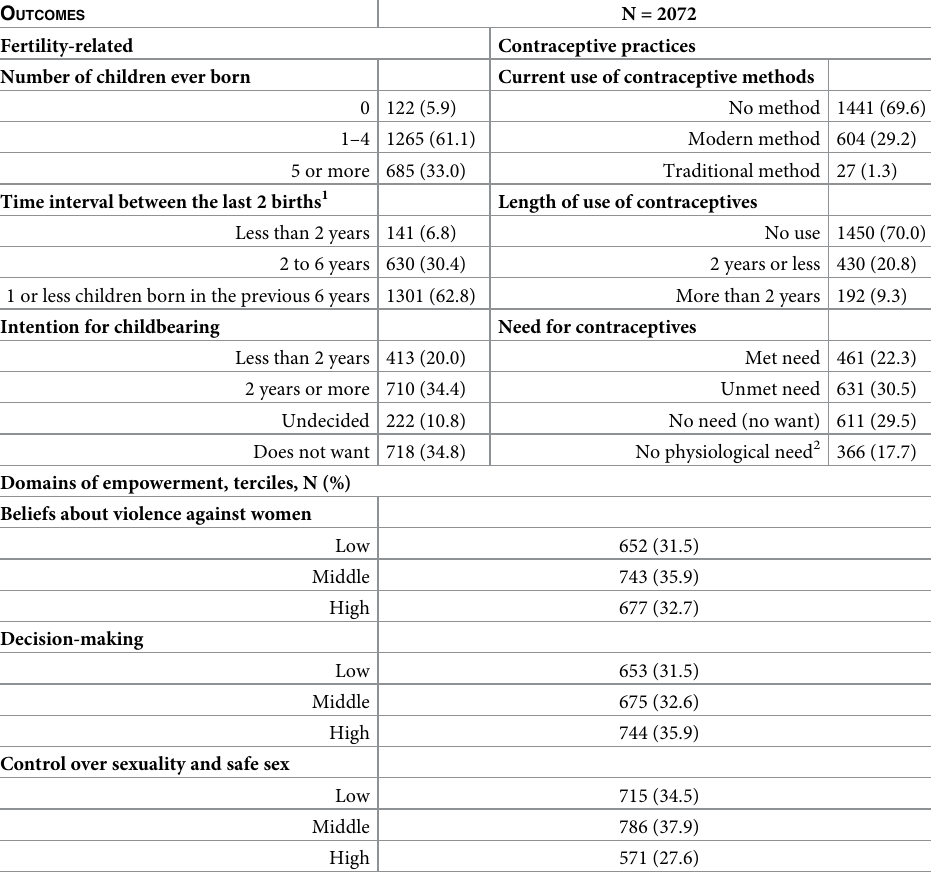
Table 2. Description of outcome variables and the empowerment domains. O UTCOMES N = 2072 Fertility-related Contraceptive practices Number of children ever born Current use of contraceptive